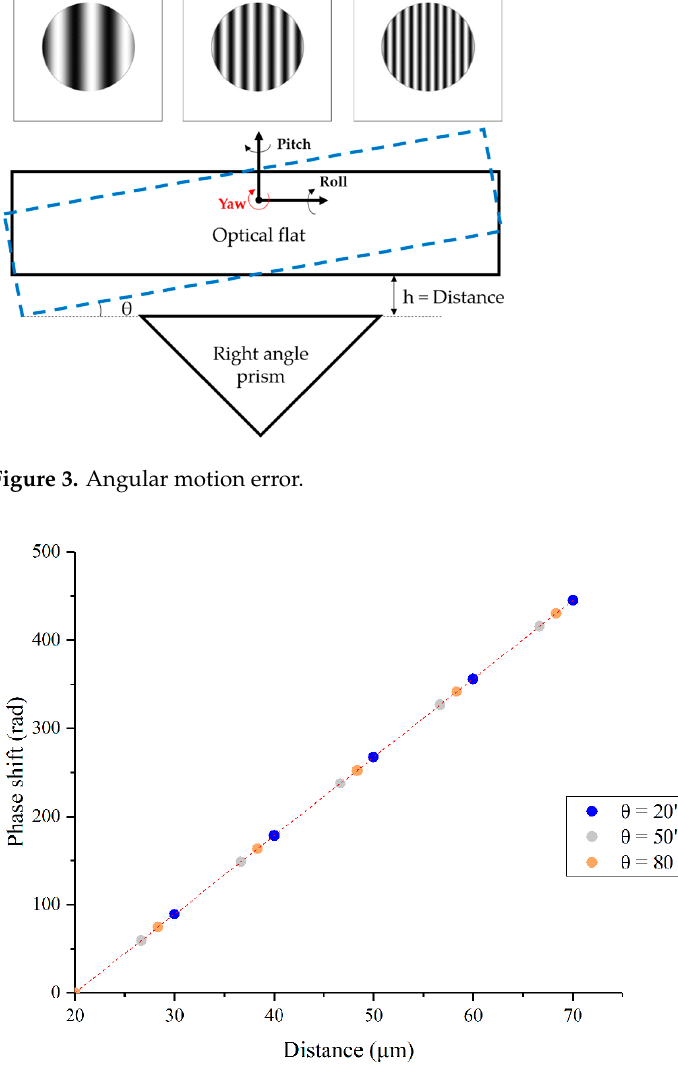
Figure 4. Simulation results of the phase shift at different angles.